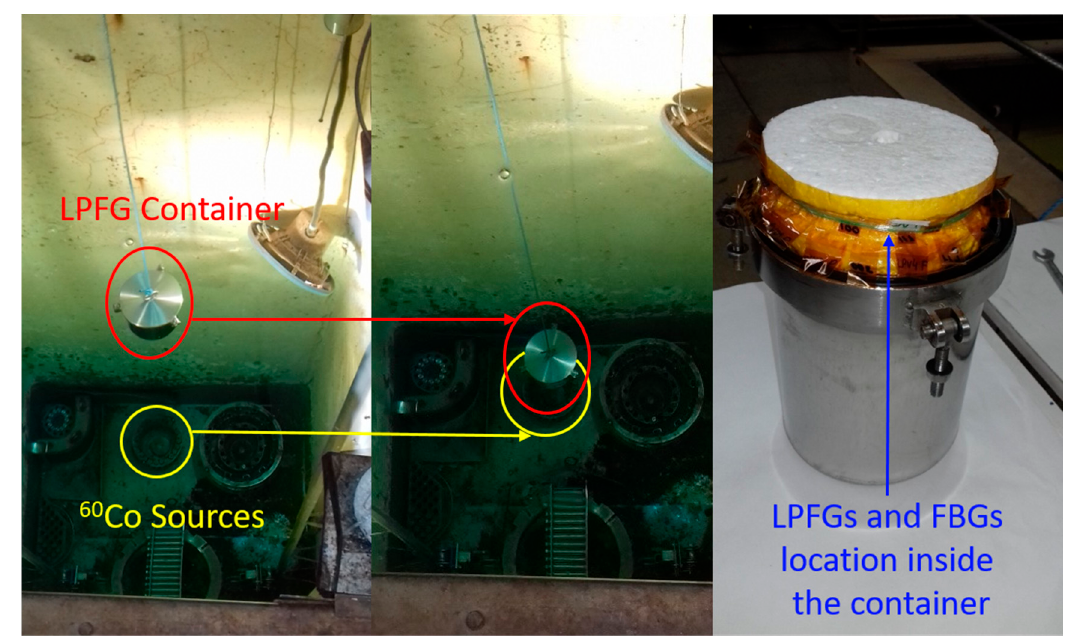
Figure 2. Left: snapshot of mounting process of the container descending inside the pool. Middle: irradiation facility setup during irradiation; view of the container located at the bottom of the pool and the 60 Co sources in a circular configuration. Right: Waterproof container with LPFGs and FBGs rolled-up inside.